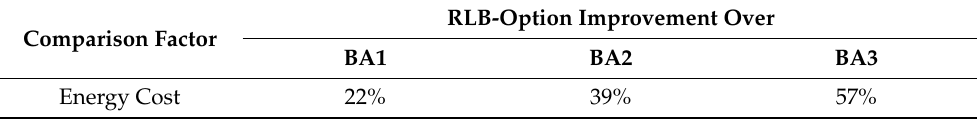
Table 2. RLB-Option improvement over baseline algorithms. Comparison